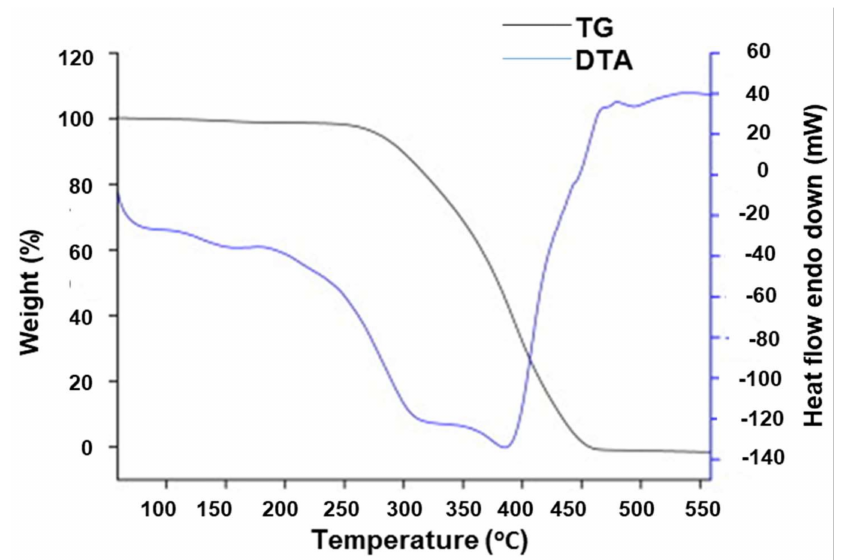
Figure 5. Thermogravimetric analysis (TG) and differential thermal analysis (DTA) of hypericin- imprinted polymer